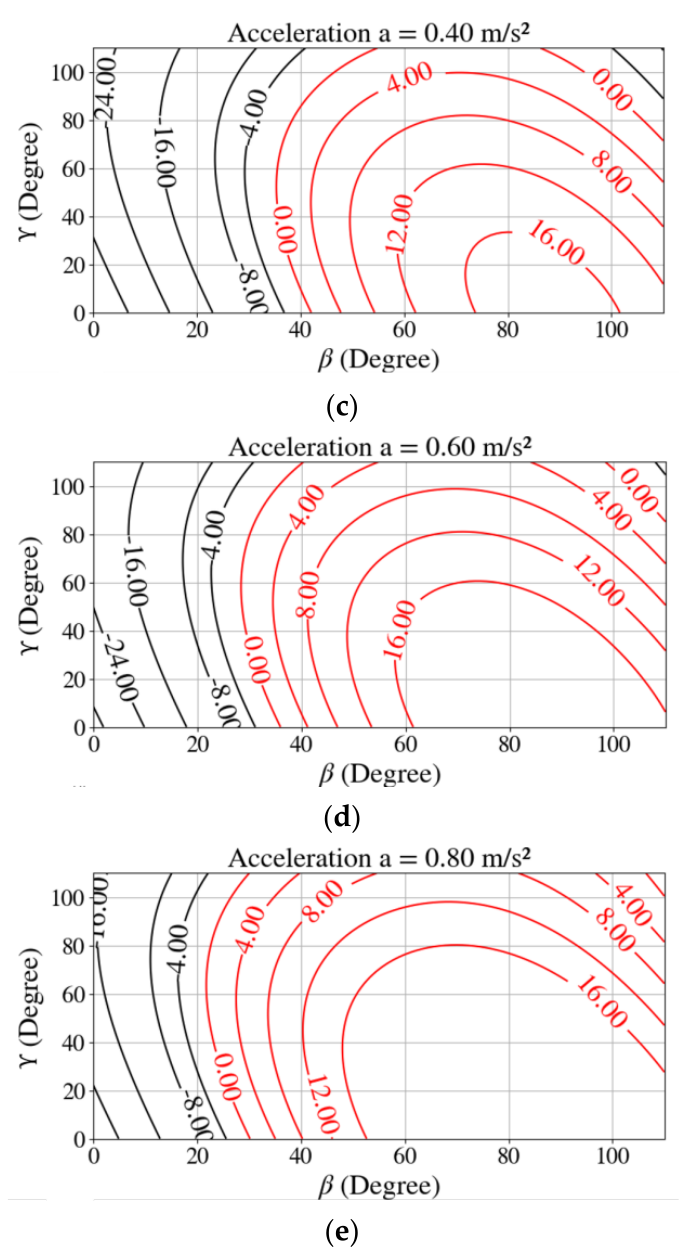
Figure 12. Analysis of the stability moment as a function of the manipulator ’ s joint positions and mobile platform acceleration, employing as linear acceleration: ( a ) 0 m/s 2 , ( b ) 0.2 m/s 2 , ( c ) 0.4 m/s 2 , ( d ) 0.6 m/s 2 , and ( e ) 0.8 m/s 2 . The black lines represent stable states and the red lines represent unstable states of the mobile manipulator.